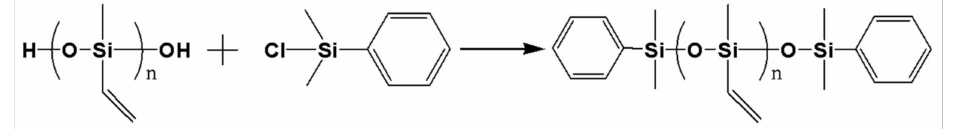
Figure 3. The reaction to quantification of molecular